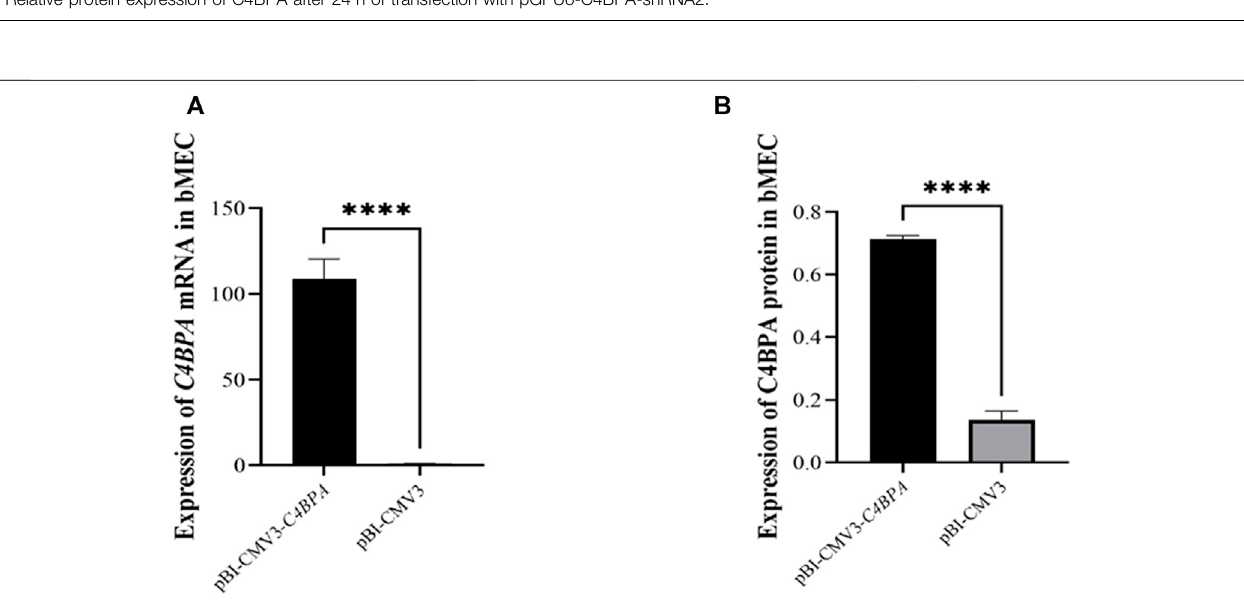
FIGURE 3 | (A) Relative mRNA expression of C4BPA gene after 24 h transfection with pBI-CMV3- C4BPA and pBI-CMV3 in bMECs. (B) Relative protein expression of C4BPA gene after 24 h transfection with